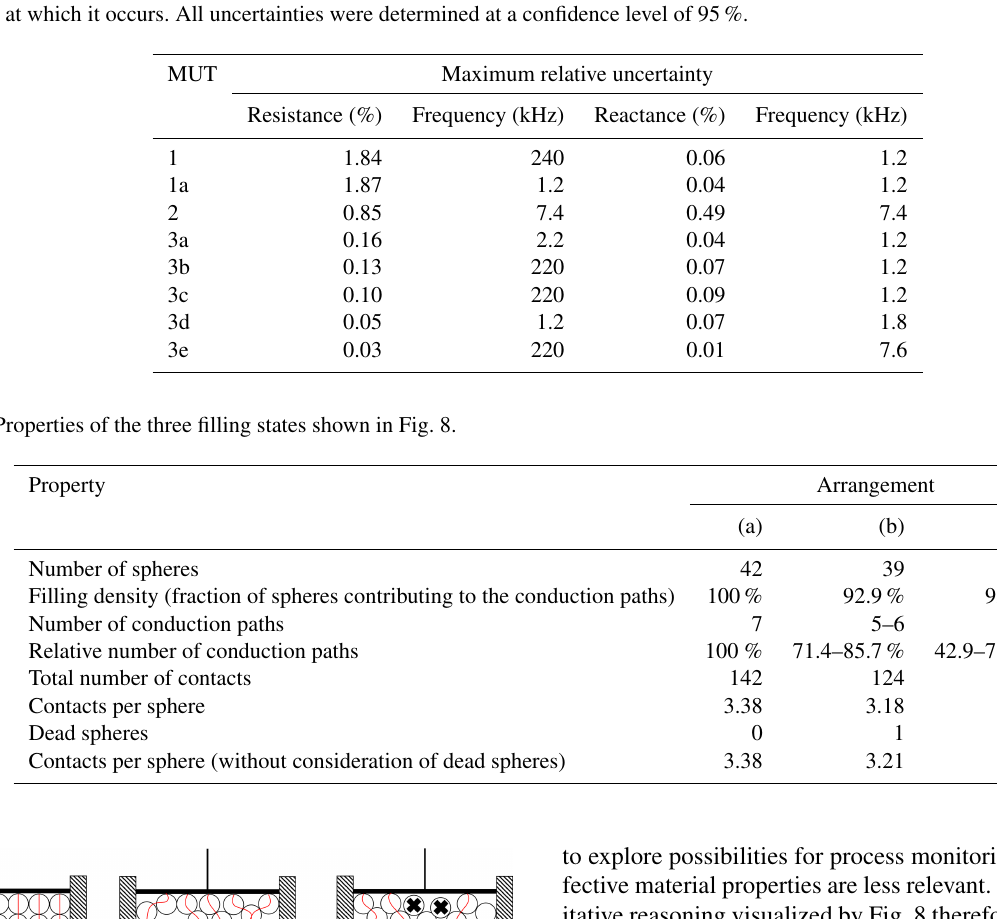
Table 2. Maximum relative uncertainty of the measured cell impedance with different types of material under test (MUT) and the respective frequency at which it occurs. All uncertainties were determined at a confidence level of 95%.